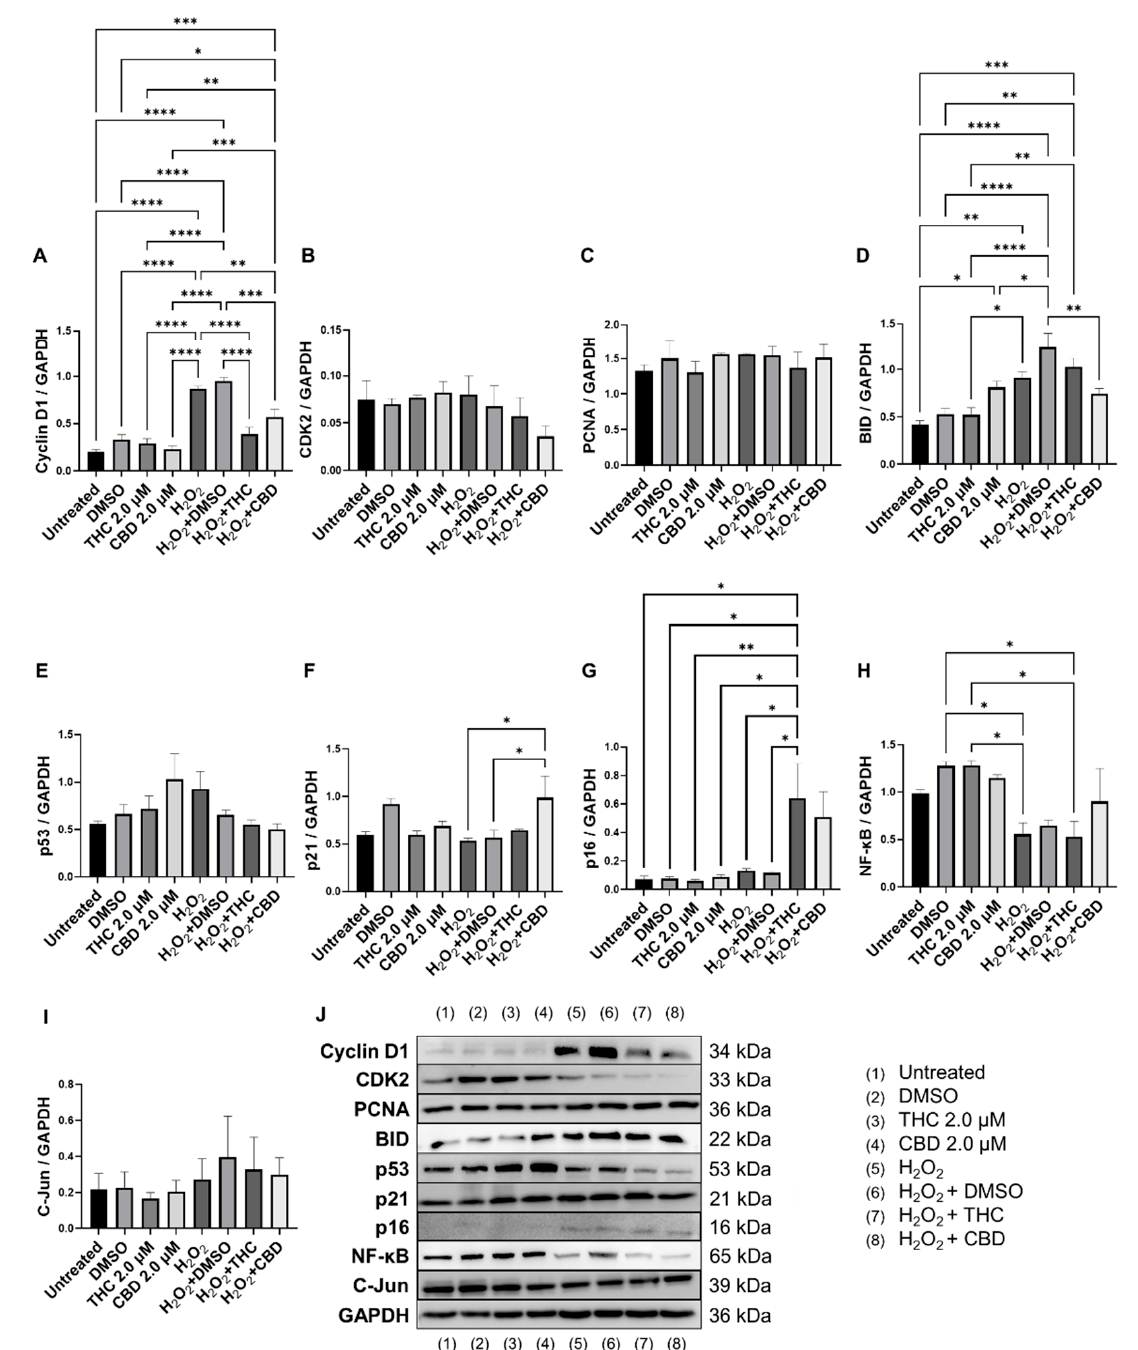
Figure 9. Effects of phytocannabinoids on cell cycle regulators in CCD-1064Sk human dermal fibroblasts (PDL 24). Relative densitometry was presented as a ratio of the target protein relative to GAPDH for expression of ( A ) Cyclin D1, ( B ) CDK2, ( C ) PCNA, ( D ) BID, ( E ) p53, ( F ) p21, ( G ) p16, ( H ) NF- κ B, and ( I ) C-Jun. ( J ) representative images blots with each protein detected. Original mem-